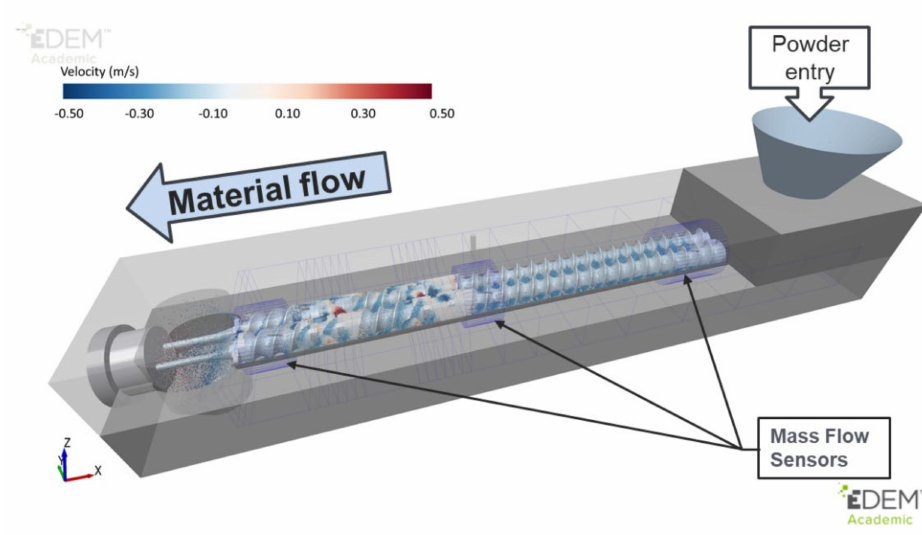
Figure 2. Full − scale DEM model of ConsiGma 1/25.